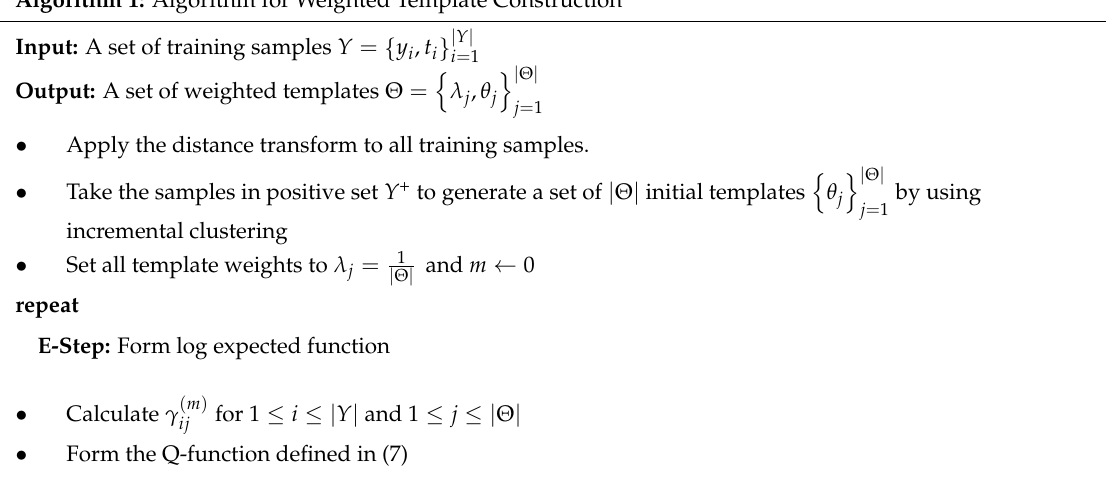
Algorithm 1: Algorithm for Weighted Template Construction